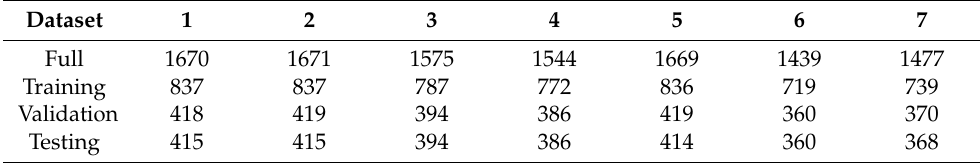
Table 3. Number of cases belonging to particular variants.